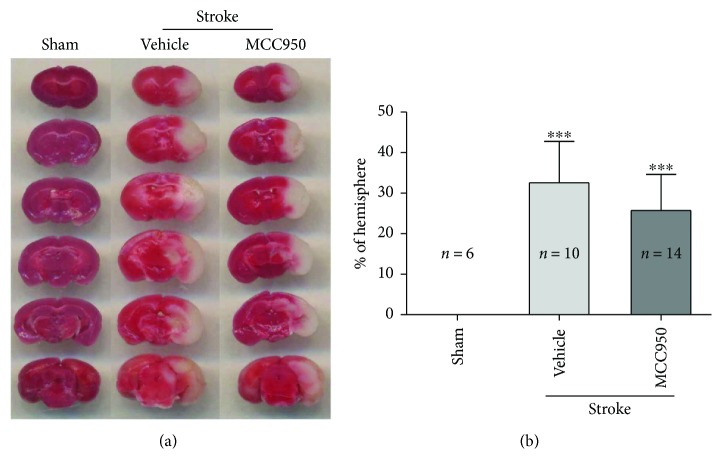
NLRP3 inhibition had no effect on the infarction size in diabetic mice after 24 hr MCAO. The left panel showed that representative 2% TTC-stained coronal sections indicated infarctions in the sham and stroke group. Quantification of the infarct volume was represented as a percent of the hemispheric volume 24 hr poststroke (shown in the right panel). Compared to the sham group, the stroke group showed conspicuous infarction volume percentage in diabetic mice (∗∗∗P < 0.001). Fifty milligrams per kilogram of MCC950 had no significant effect on the infarct size compared with the vehicle in diabetic mice (P > 0.05). ∗∗∗P < 0.001 compared with the sham group.